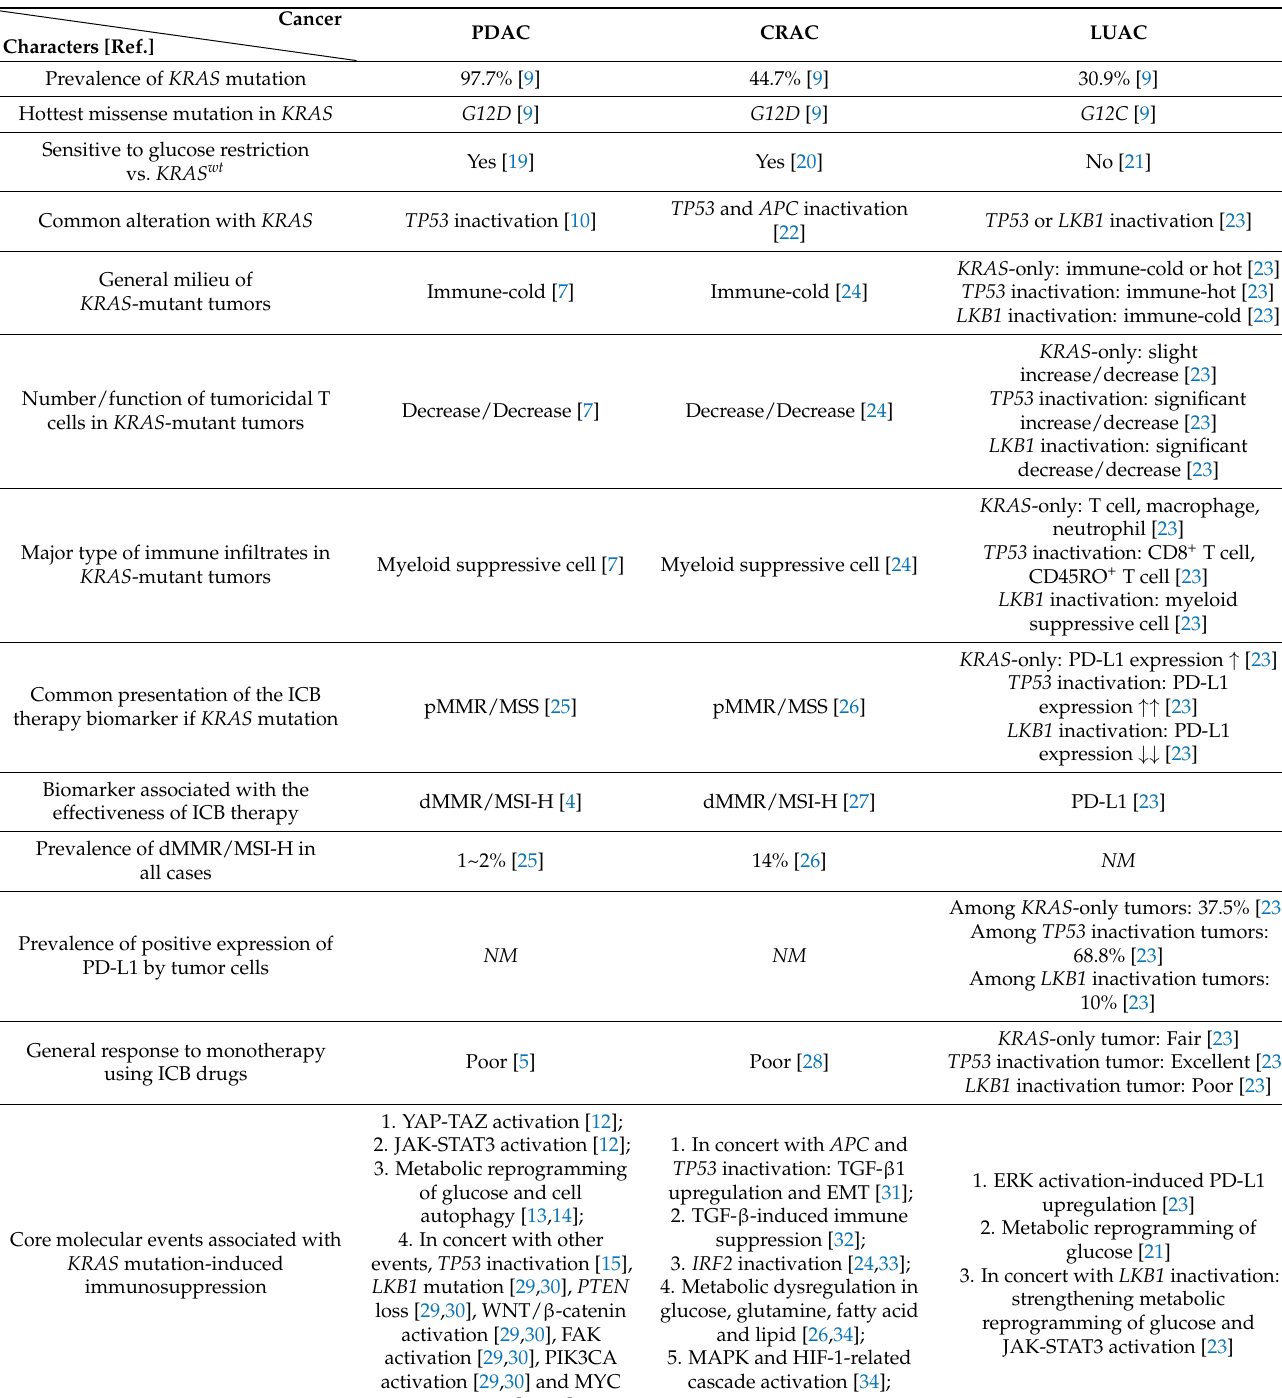
Table 1. The comparison of immune-related characteristics among KRAS -mutant